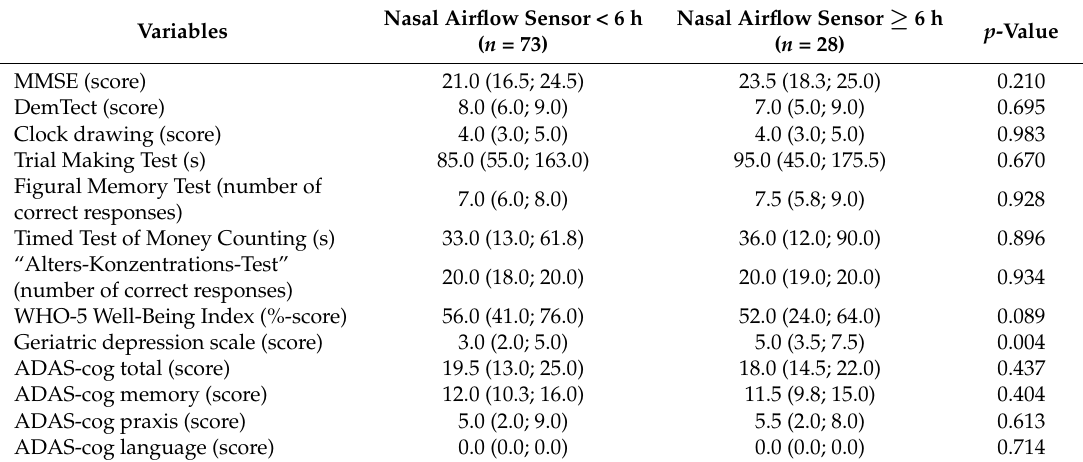
Table 6. Cognitive and emotional function split by tolerance of the nasal airflow sensor ≥ 6 h vs. <6 h.